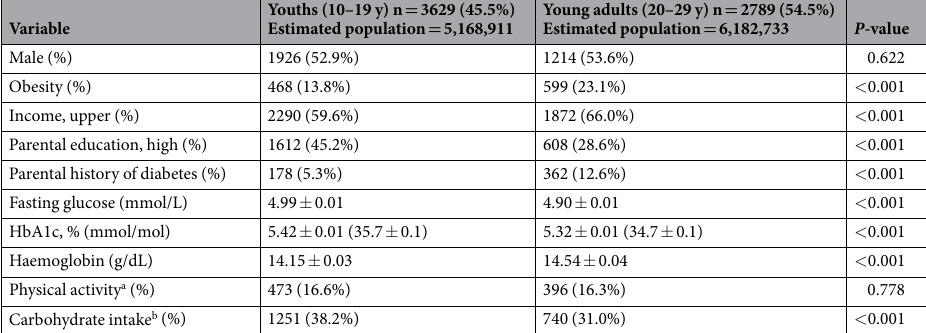
Table 1. Clinical characteristics of study participants. Data are expressed as the weighted mean ±